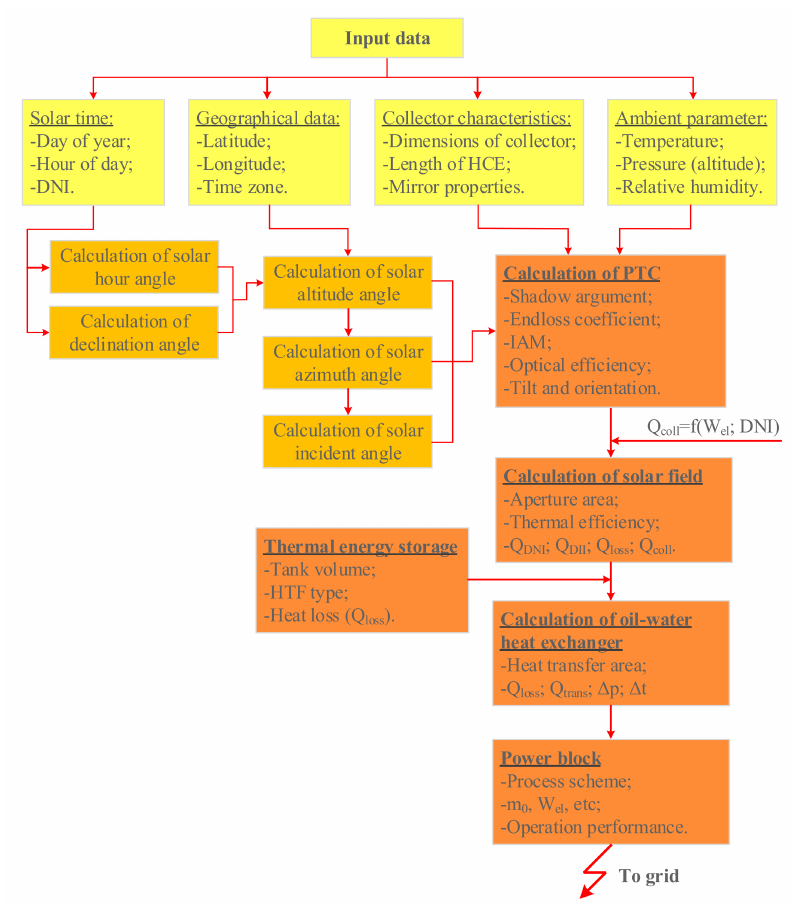
Figure 1. Simplified logic flow diagram for estimating the operating performance of the CSP